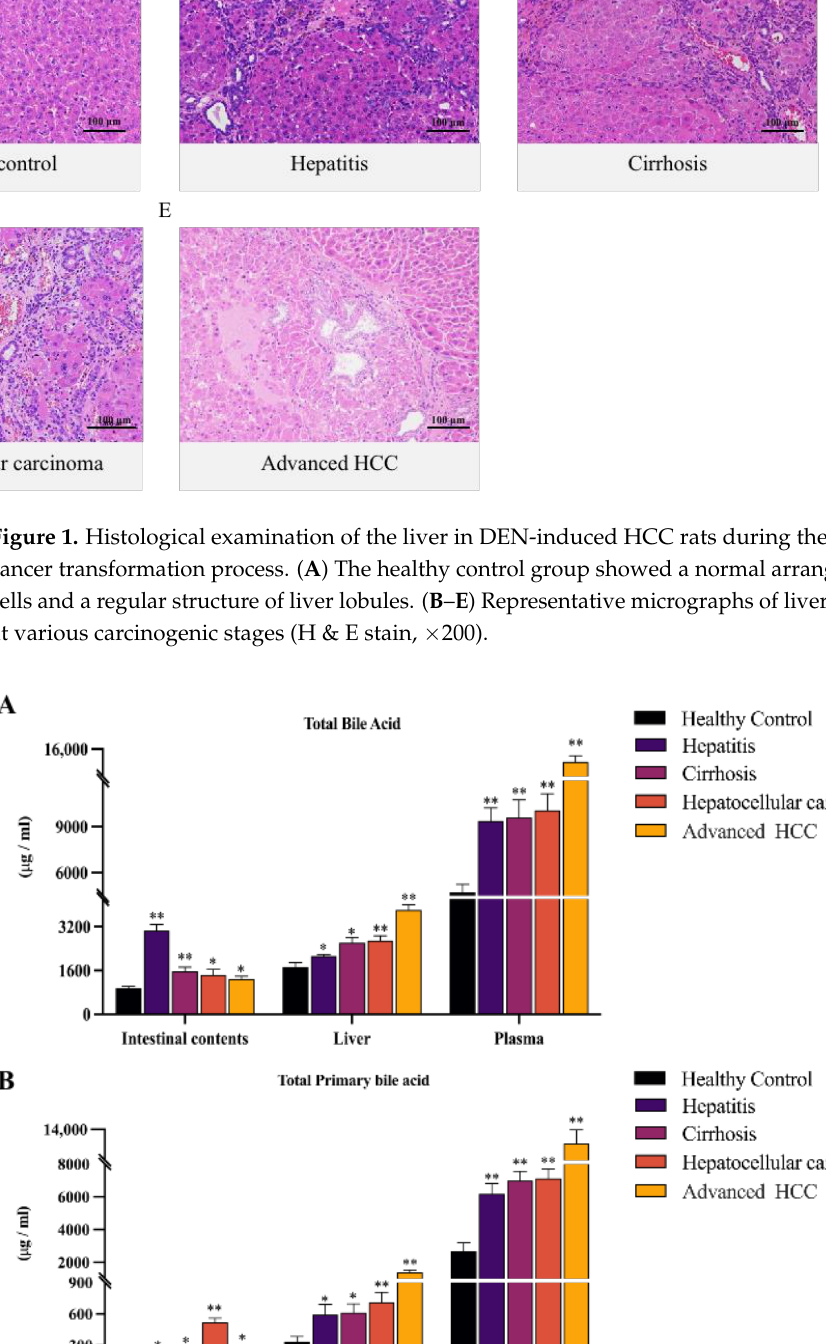
Figure 2. The variations of TBA, total primary BAs, and total secondary BAs in different specimens of DEN-induced HCC rats at healthy, hepatitis, cirrhosis, HCC, and advanced cancer stages. ( A ) TBA concentrations were significantly higher than blank controls in plasma, liver, and intestinal contents samples, and positively correlated with disease progression in plasma and liver. ( B ) The level change of total primary BAs was basically identical between plasma, liver, and intestinal contents, which were significantly elevated at all stages. ( C ) Total secondary BA levels were elevated in plasma and intestinal contents samples while significantly decreased in liver samples over the full course of the disease. The Figure indicates statistical significance compared with healthy controls by t -tests. * p < 0.05, ** p < 0.01. 2.2. Observing Liver – Gut Axis BAs Environment and Screening HCC Biomarkers for Early Diag- nosis To figure out the key driving BAs for the evolving of HCC, we quantified the changes in the levels of 5 free BAs (cholalic acid, CA; chenodeoxycholic acid, CDCA; ursodeoxy- cholic acid, UDCA; lithocholic acid, LCA; deoxycholic acid, DCA; Figure 3), and their asso- ciated 10 conjugated BAs in plasma, liver, and intestine (Figure 4). The quantitative results of 15 BAs in plasma, liver, and intestinal contents samples from different disease stages of HCC and healthy controls are included in Table S3, and the results are expressed as mean ± SD.